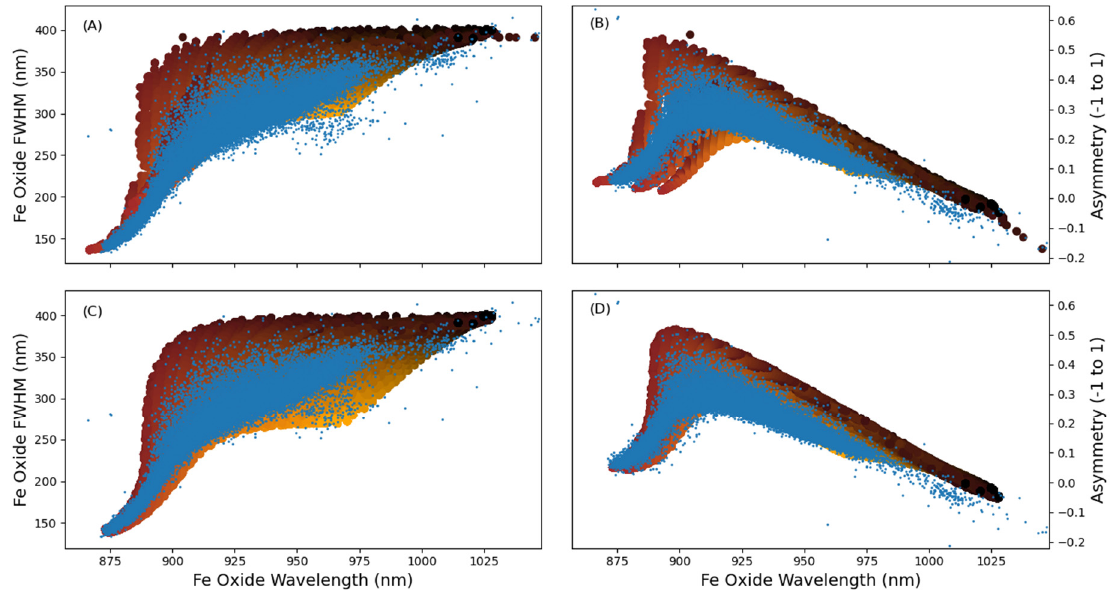
Figure 10. The measured iron boomerang distribution is shown in blue while the base model distri- butions sit behind and are shown in an RGB scheme for hematite (brown), ochreous (orange), and vitreous goethite (black). ( A , B ) show the mixing space generated from the library endmembers of hematite, ochreous and vitreous goethite. ( A ) is the iron boomerang while ( B ) is the Fe Oxide Wave- length versus the Fe Oxide Asymmetry. Selecting in-situ hematite and ochreous endmembers, the vitreous is supplied from the library, leads to ( C,D ),